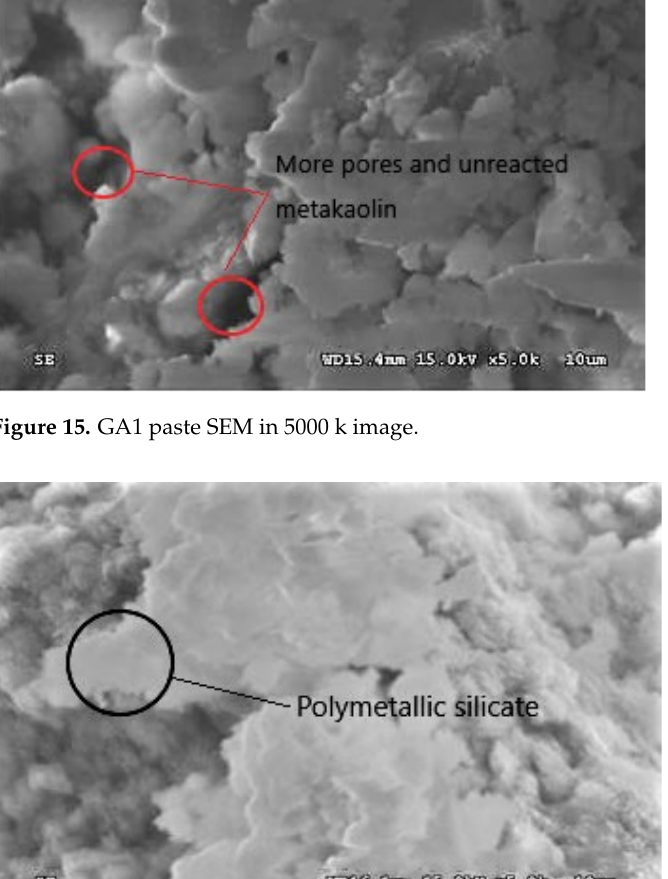
Figure 17. GA7 paste SEM in 5000 k image. Figure 18. GS1 paste SEM in 5000 k image.